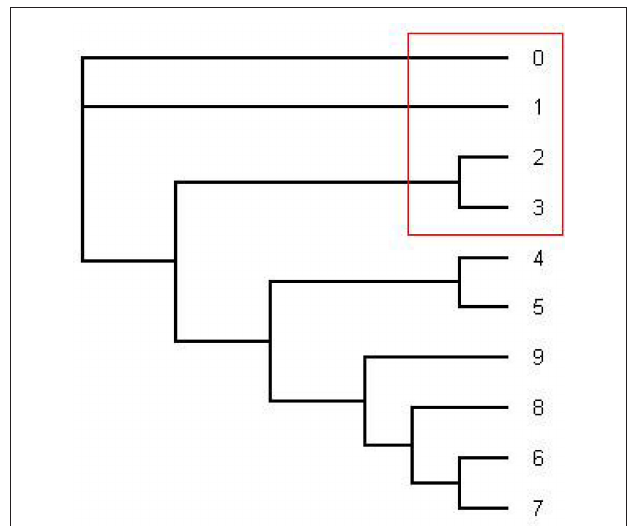
Figure 1 | This is the tree topology written in pink (series 14) in Figure 2. This is an unrooted tree. This is the most likely tree topology from position 1 to 140 and position 300 to 1000. The software from Webb et al. (2009) and RDP3 Martin et al. (2005b) indicate a potential recombination event among taxa 0, 1, 2, and 3 in the red rectangle. Also the ML tree estimated by the software PHYML has the same tree topology under HKY model as well as the consensus tree estimated by the software MrBayes under HKY and GTR + Γ .